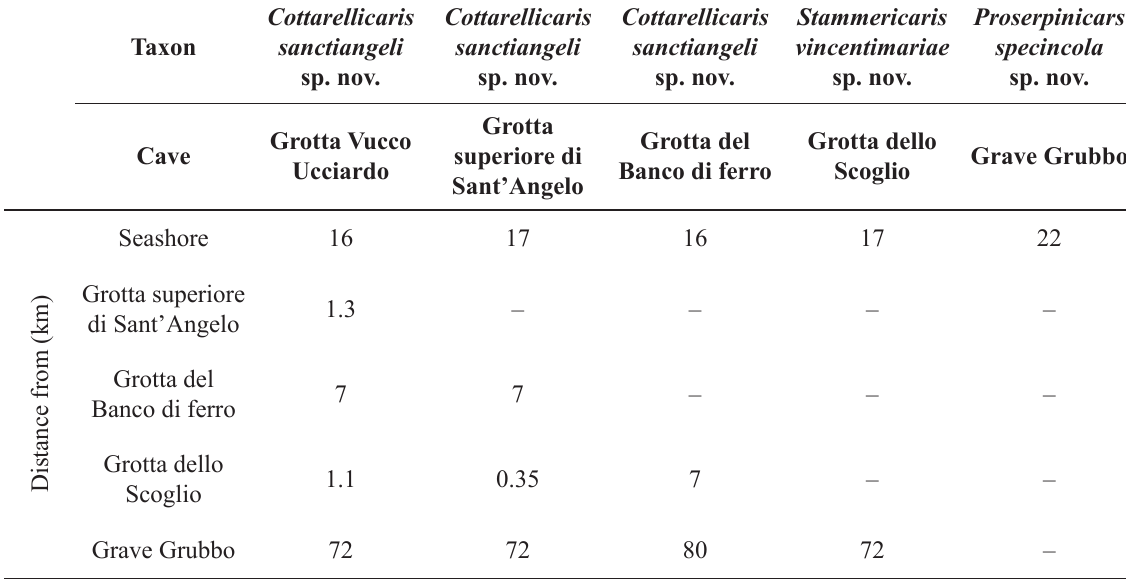
Table 1. Estimated distances between caves and from the seashore for each